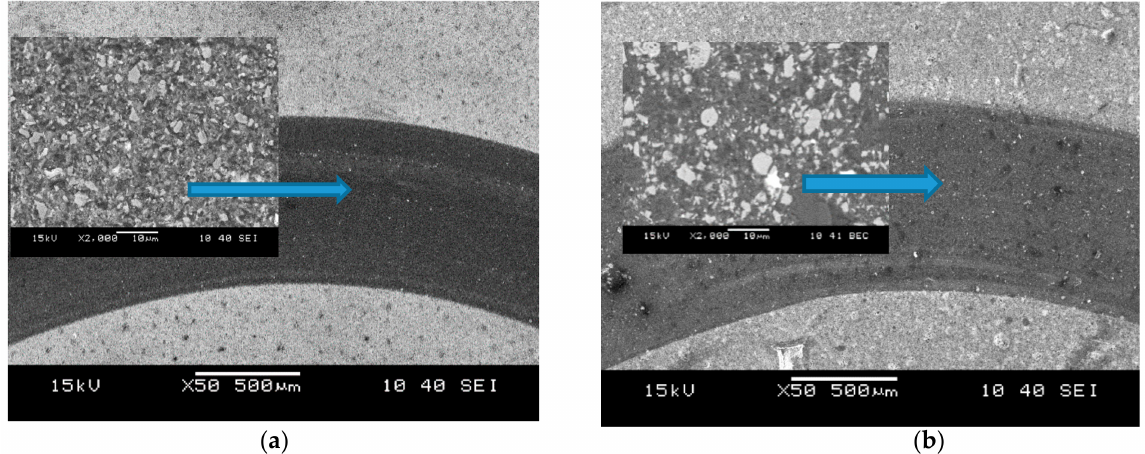
Figure 11. Microstructure of the wear track for composites: ( a ) TICN5.1; ( b )